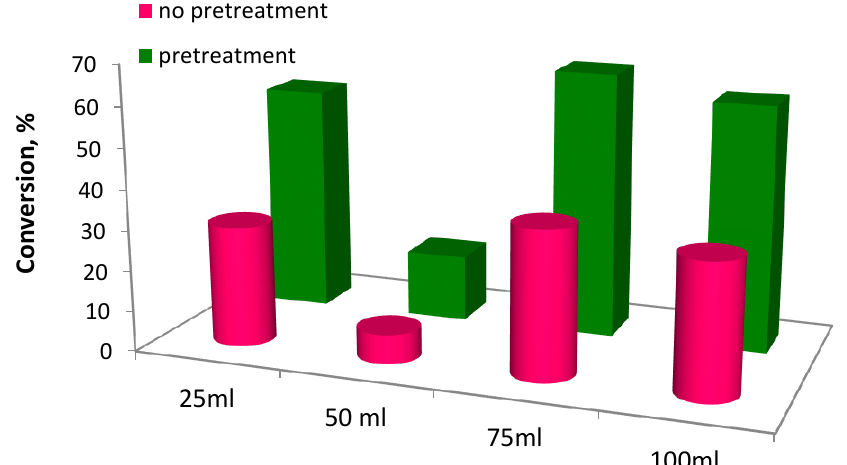
Figure 10. The dependence of maleic acid conversion on the SCS catalysts, calculated from the quantity of absorbed hydrogen.